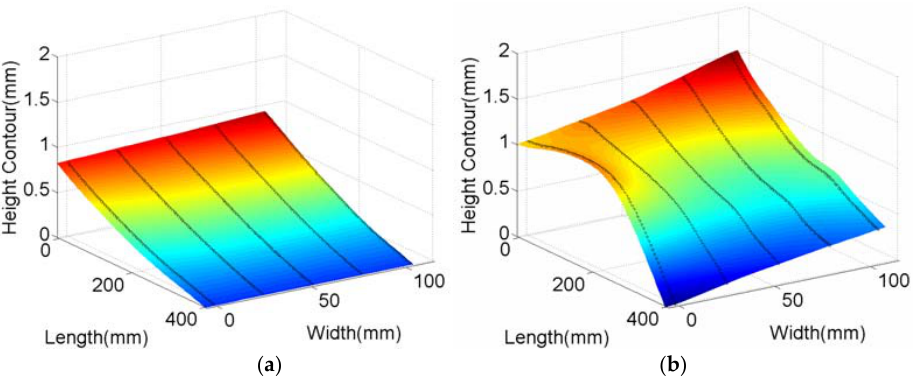
Figure 7. Surface contour maps of the sample surface. ( a ) After quenching; ( b ) After machining.